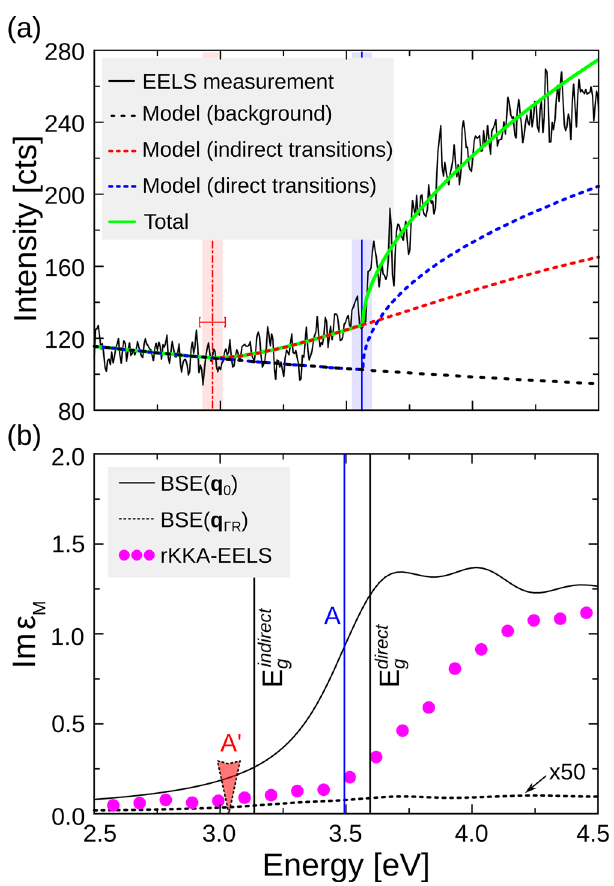
Fig. 5 Comparison between theory and experiment. a Electron energy-loss spectroscopy (EELS) measurement (black solid line) of a BaSnO 3 single crystal in the energy range around the absorption onset. The fi ts obtained by a model assuming either indirect or direct transitions (see “ Methods ” section) are shown by the red and blue dashed lines, respectively. The dashed black line refers to the background model while the green solid line shows the sum of the three models. The vertical blue line indicates the onset of direct transitions and the dashed red line that of indirect transitions; the shaded areas represent their error bar. b Dielectric function in the energy range of the absorption onset given by Bethe – Salpeter equation (BSE, black solid line) and determined from EELS measurement (magenta circles). The intensity of the BSE spectrum for momentum transfer q = q ( Γ R ) = (1/2,1/2,1/2), shown by the dashed line, is scaled by a factor of 50 for better visibility. A Lorentzian broadening of 0.2 eV is applied. The blue line indicates the fi rst direct excitation (optical gap) obtained for q 0 = (0,0,0) (A), the red arrow refers to the fi rst indirect transition for q = q Γ R (A ′ ). Both BSE spectra are corrected by a value of − 0.367 eV to account for band-gap renormalization due to zero-point vibrations and